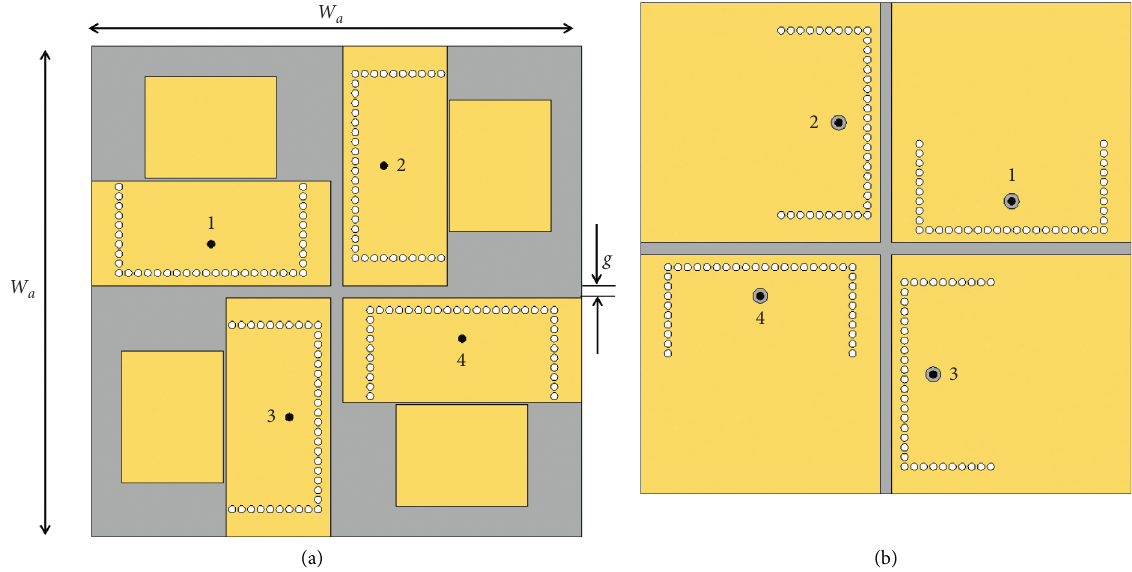
Figure 4: Simulated electric field distribution on the dual-band antenna at the two resonant frequencies: (a) f (b) f H � 5.38GHz.